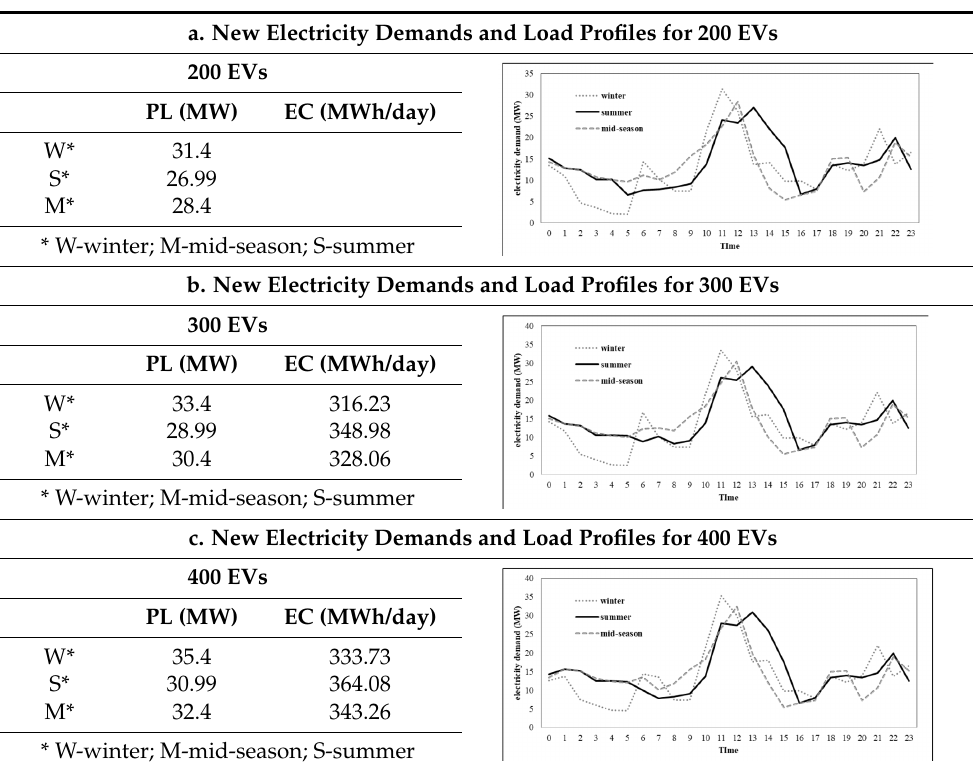
Table 8. New electricity utilization patterns with different scales of EVs in Xizhou